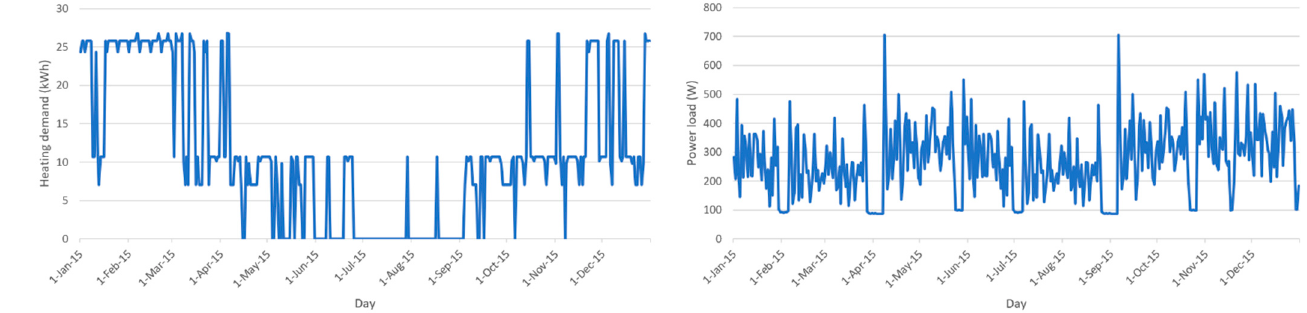
Figure 2. Input heat demand profile ( left ) and electrical load curve ( right ) over one year [3].